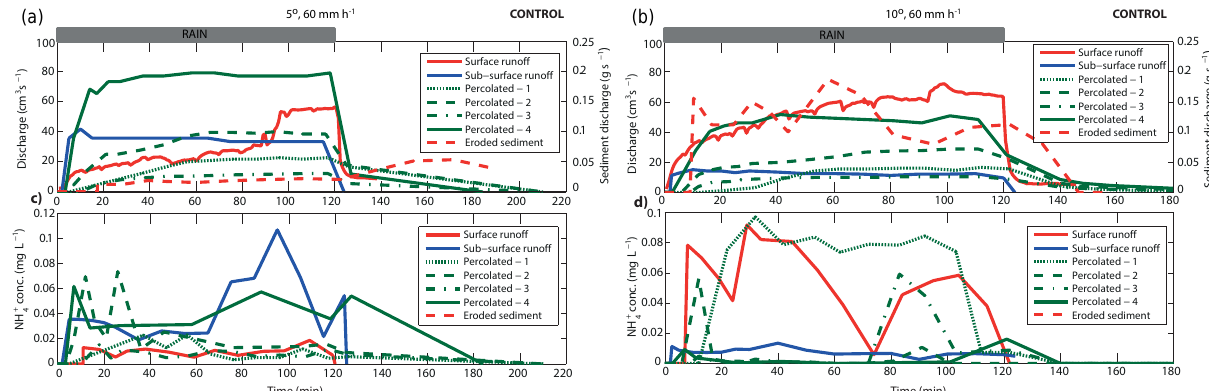
Figure 4. Plots showing water and sediment discharge (a, b) and NH + concentrations (c, d) from each monitored flow pathway for the 4 control experiments (no slurry) at two slope angles (5 and 10 ◦ ) at 60mmh − 1 rainfall intensity. Where percolated 1–4 represent vertical transport from each of the pairs of tanks beneath the soil slope as marked in Fig. 1.